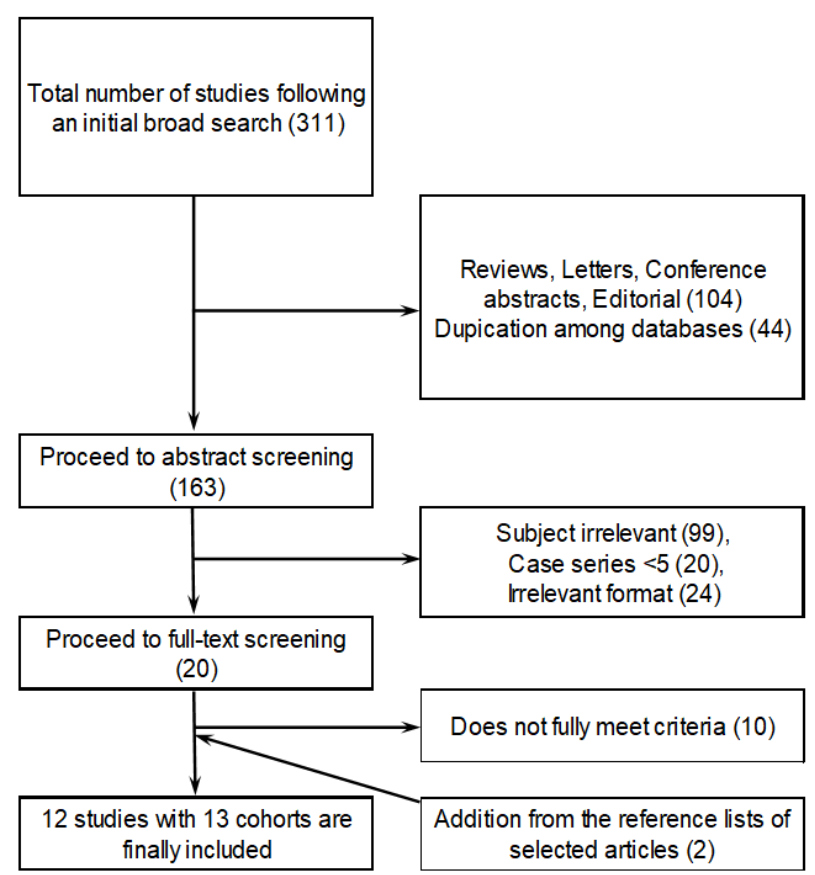
Figure 1. Flowchart showing the study selection process.